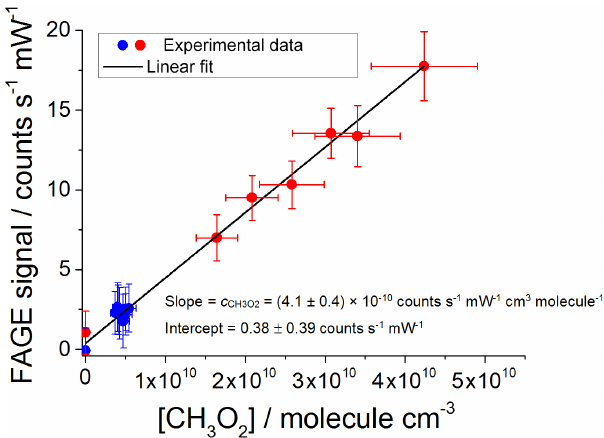
Figure 5. FAGE calibration for CH 3 O at atmospheric pressure and 293K; laser power P = 12 . 9 ± 0.3mW and pressure in the detec- tion cell is 2.65 ± 0.05Torr. The FAGE signal, including the mea- surement with the Hg lamp turned off ([CH 3 O] = 0), was obtained after subtraction of the offline signal, 12.3 ± 0.9countss − 1 mW − 1 . Averaging time per point = 120s. The error limits in [CH 3 O] and the FAGE signal for the x and y axes respectively are representative of the 1 σ overall uncertainty, which contains the total systematic and statistical errors (see text for details of these). The error limits shown in the legend are the standard errors in the slope and intercept of the fit to the experimental data.